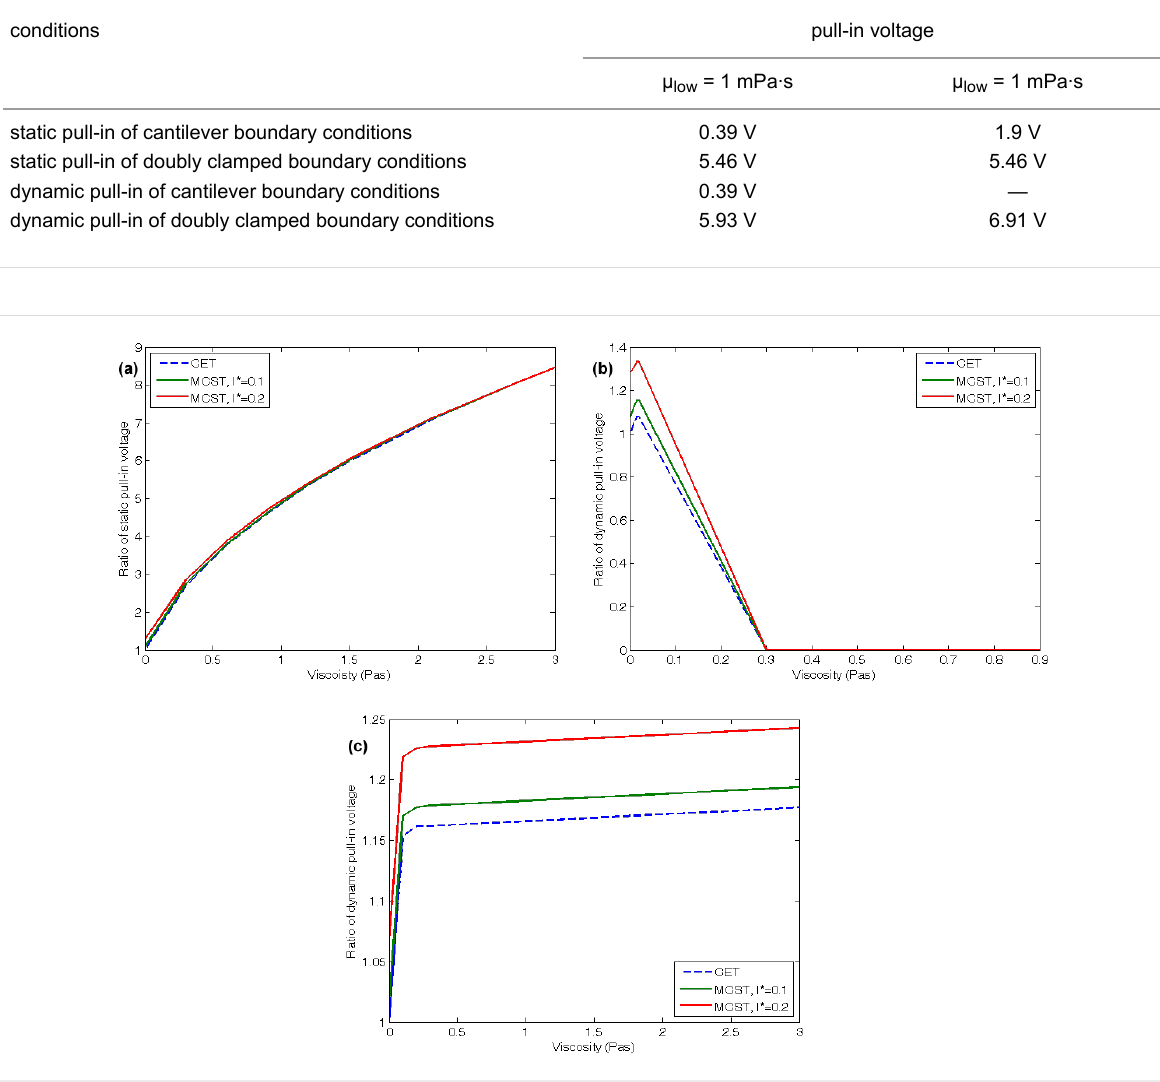
Figure 6: Effects of viscosity on (a) static pull-in voltages of the cantilevered CNT, (b) dynamic pull-in voltages of the cantilevered CNT, (c) dynamic pull-in voltages of the doubly clamped